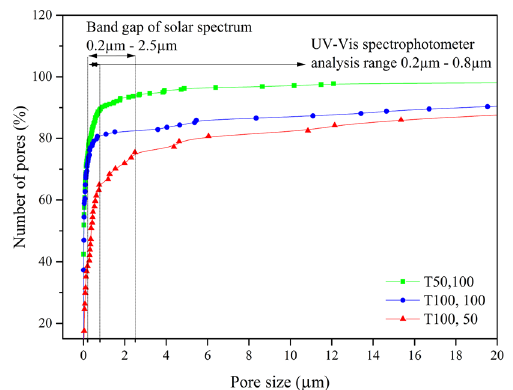
Figure 5. Accumulated percentage distribution of pore size for an area of 2500 µm 2 highlighted in figure